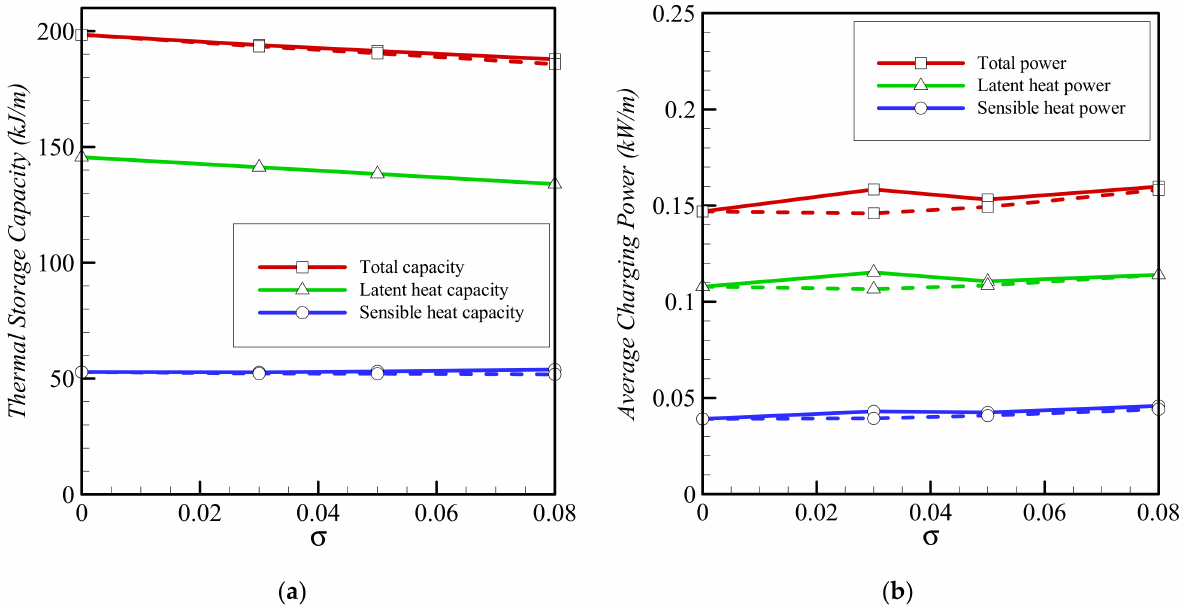
Figure 16. Variations of average thermal storage capacity ( a ) and average charging power ( b ) as functions of the volumetric fraction of copper nanoparticles indicated by solid lines and graphite oxide nanoadditives indicated by dash lines for porosity ε = 0.80 and eccentricity e = 0.12 r s